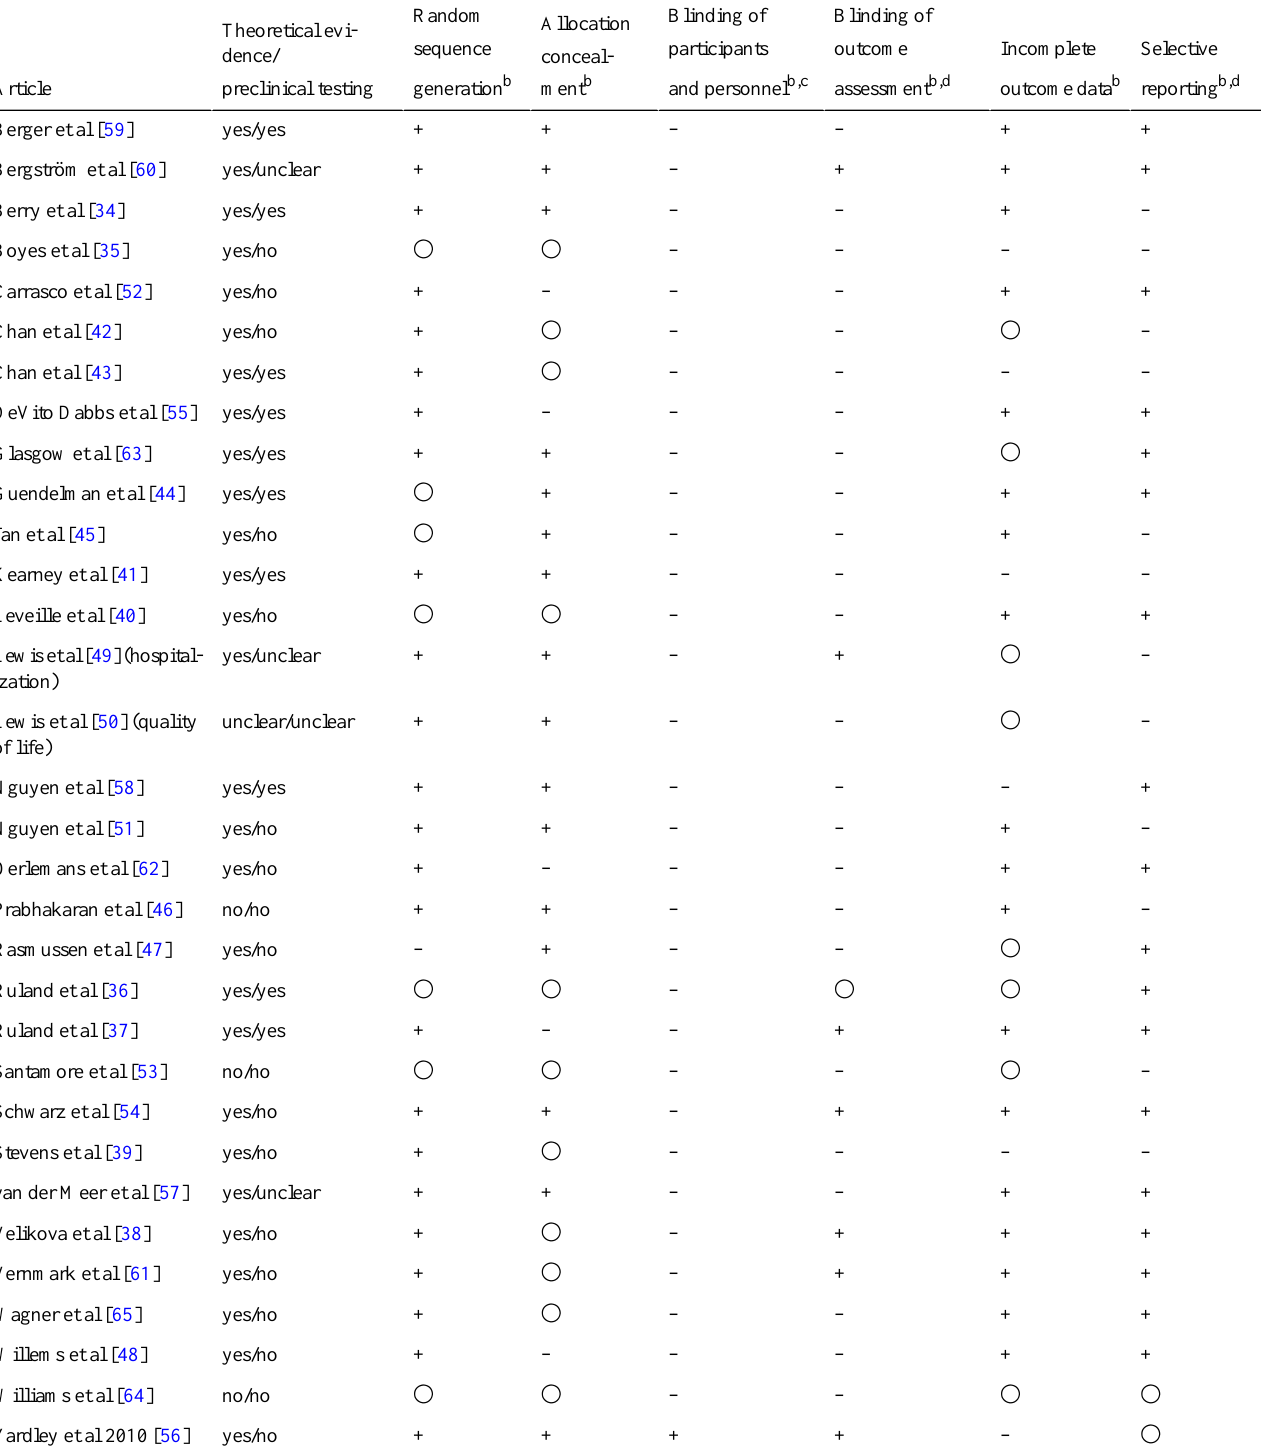
Table 1. Judgments of methodological quality in the reviewed randomized controlled trials of electronic symptom reporting a